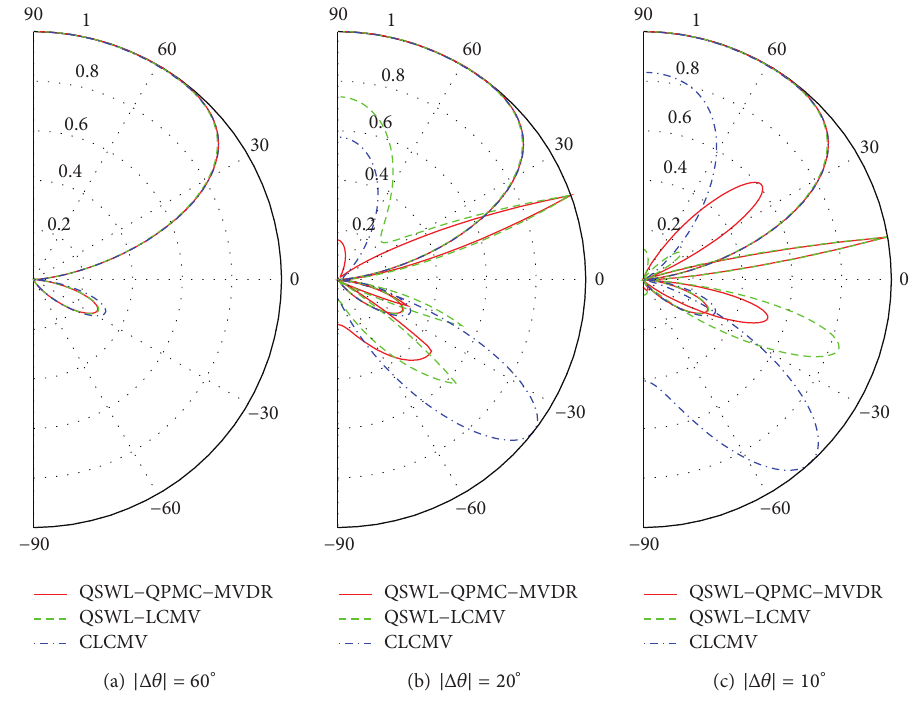
Figure 4: The power patterns at 𝜃 𝑢 = 0 ∘ and 𝜃 𝑑 = |Δ𝜃| .